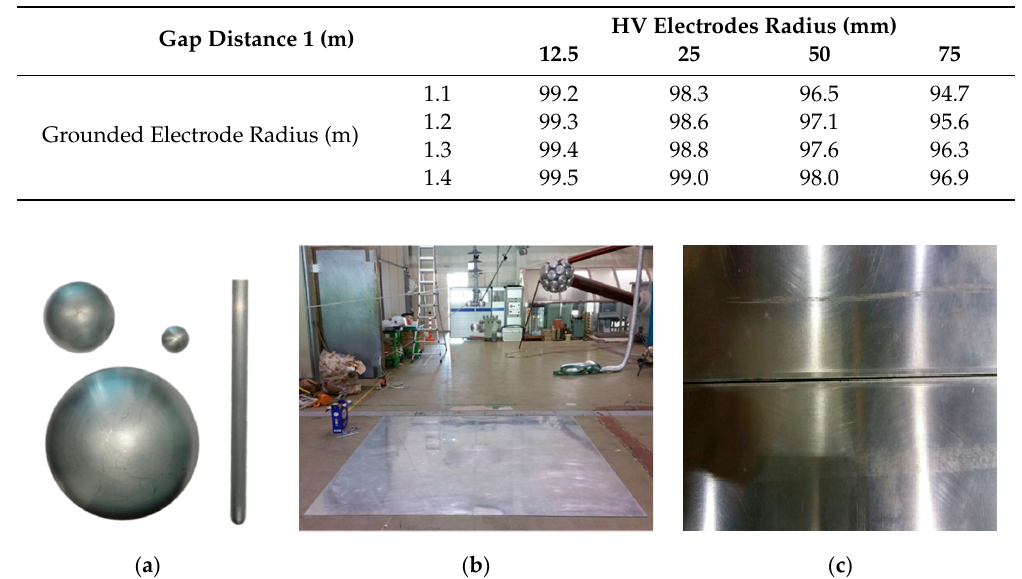
Table 2. Detailed electric field analysis result.